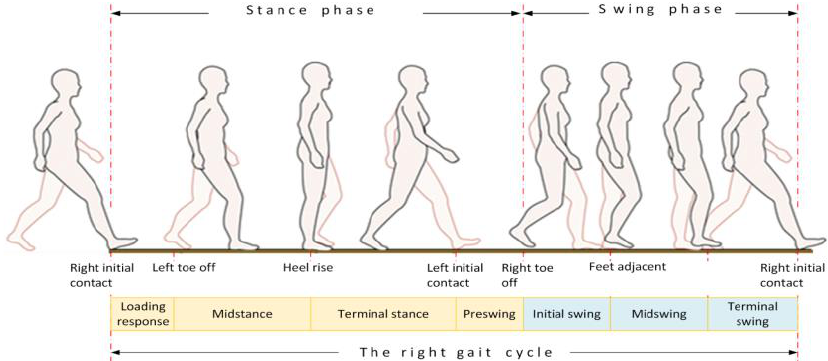
Figure 1. Gait cycle.